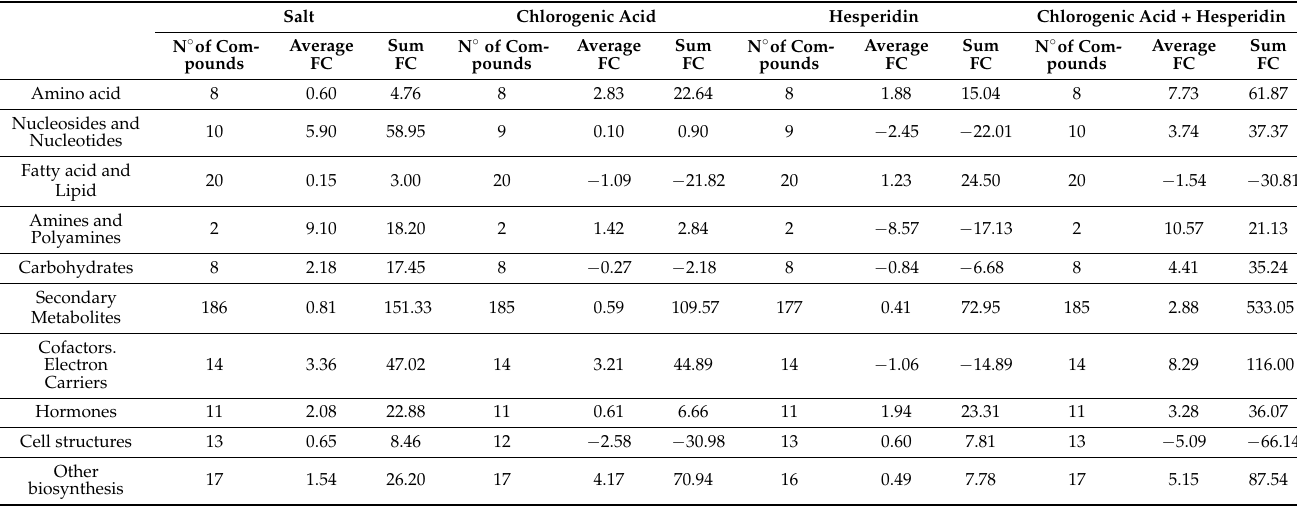
Table 2. Summary of different pathways activated on lettuce vegetables treated with 100 µ M hesperidin, 50 µ M chlorogenic acid, 100 µ M HES + 50 µ M CA and grown under 40 mM of sodium chloride (NaCl). For each pathway highlighted under different treatments, the number of compounds involved, average Log fold-change value (LogFC), and sum LogFC are provided. The LogFC values refer to a pairwise comparison between each treatment vs. control